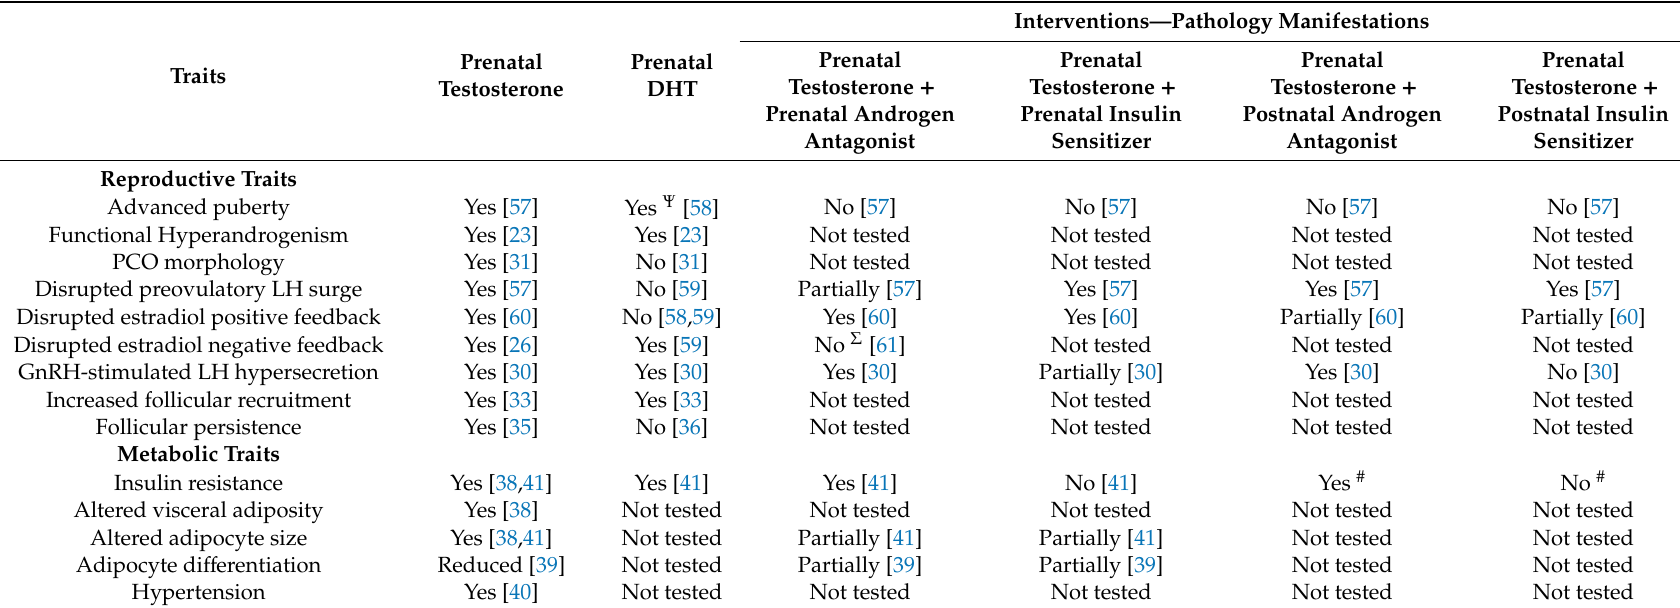
Table 1. Reproductive and metabolic disease traits in prenatal testosterone- and dihydrotestosterone (DHT)-treated sheep (2 to 3 years of age—early adulthood) and the e ff ectiveness of prenatal or postnatal interventions with either an androgen antagonist or an insulin sensitizer.